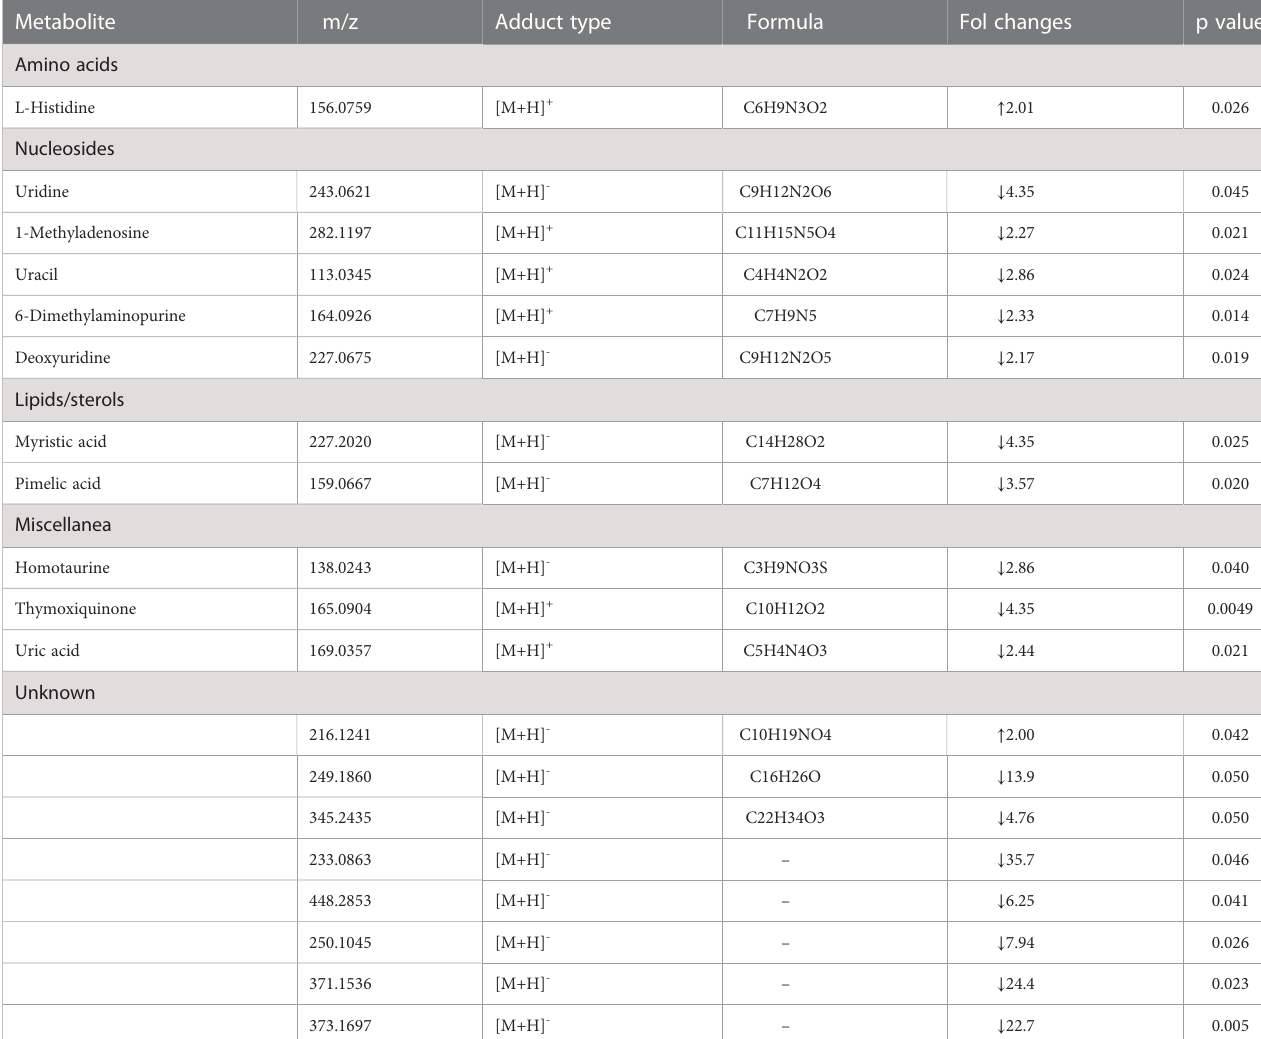
TABLE 1 Changes in the abundance of metabolites measured in individuals of Platynereis spp. collected in the Castello vent site with respect to the non- acidi fi ed San Pietro site.